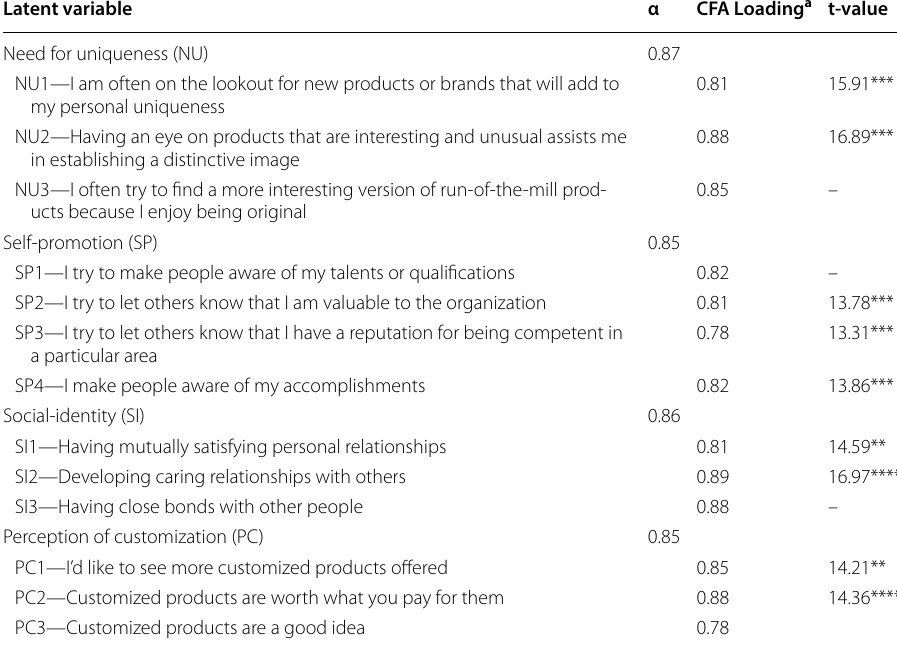
Table 1 Results of the measurement